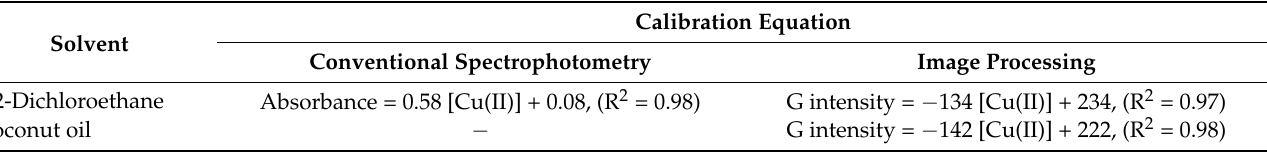
Calibration Equation